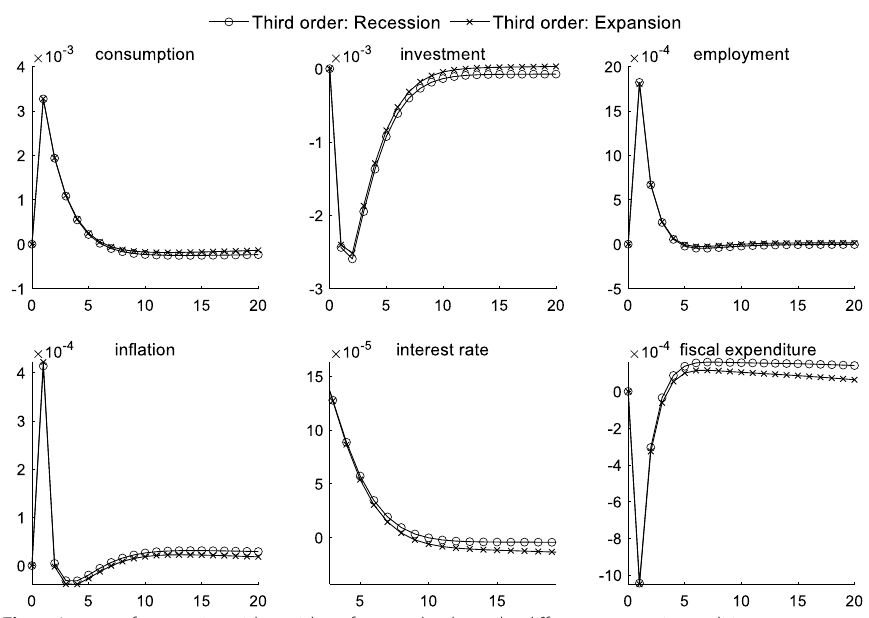
Fig. 7 Impact of uncertainty risk on risk preference shocks under different economic